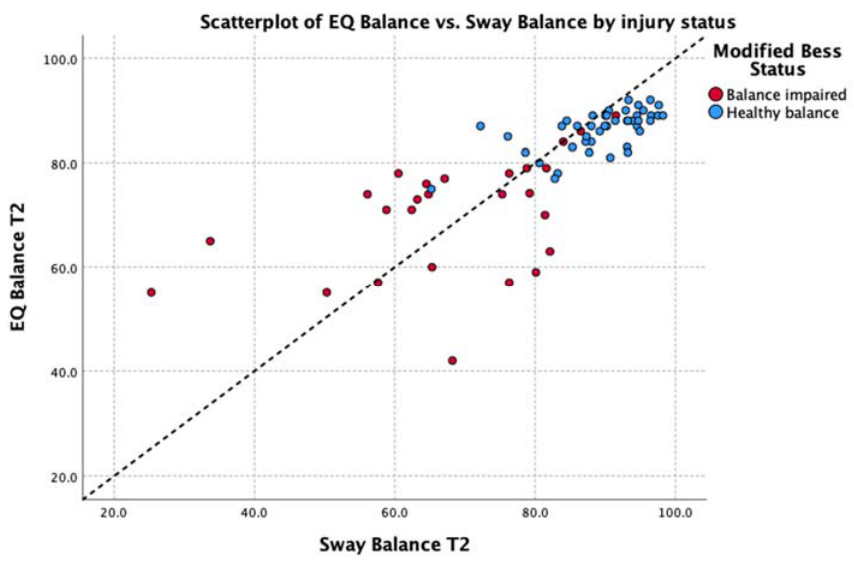
Figure 4. Relationship between the scores on the Sway Balance task and the EQ Balance task. Data points are differentially identified by balance impairment as measured by the mBESS (blue = pass, red = fail). Unity line Y = X is shown as a black dotted line.